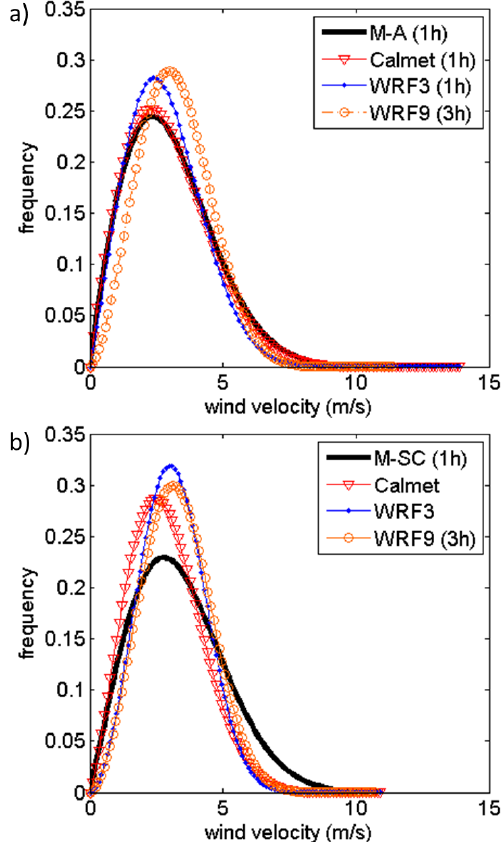
Figure 5. Weibull distributions for summer 2013 in M-A (a) and M- SC (b) . Black line for observational data (hourly) and coloured lines for each model configurations (red for CALMET, blue for WRF3 and orange for